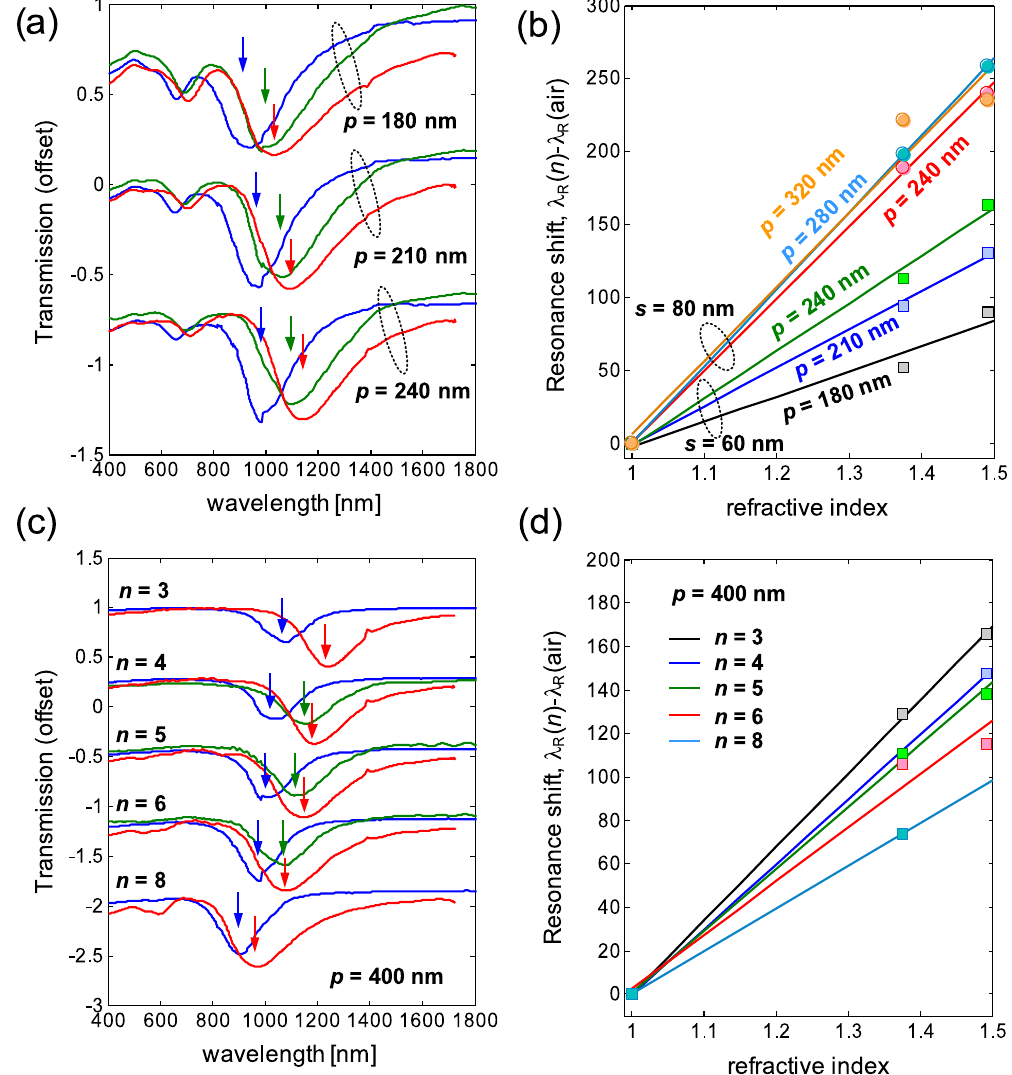
Figure 8. Bulk sensing characteristics of gammadion (Uf-SRR) and star ( C n ) structures. ( a ) Measured transmission spectra of Uf-SRR structures (s = 60 nm) coated by different claddings at different periodicities. ( b ) The Uf-SRR bulk sensitivities as a function of periodicity and size. ( c ) Measured transmission spectra of C n structures for s = 100 nm and p = 400 nm under different claddings. ( d ) The C n bulk sensitivities for s = 100 nm at p = 400 nm. The resonance positions for air, isopropyl alcohol solution, and 100-nm thick PMMA are indicated by the blue, green, and red arrows, respectively. Some measurements of isopropyl alcohol (for n = 8) were not available due to the evaporative nature of the